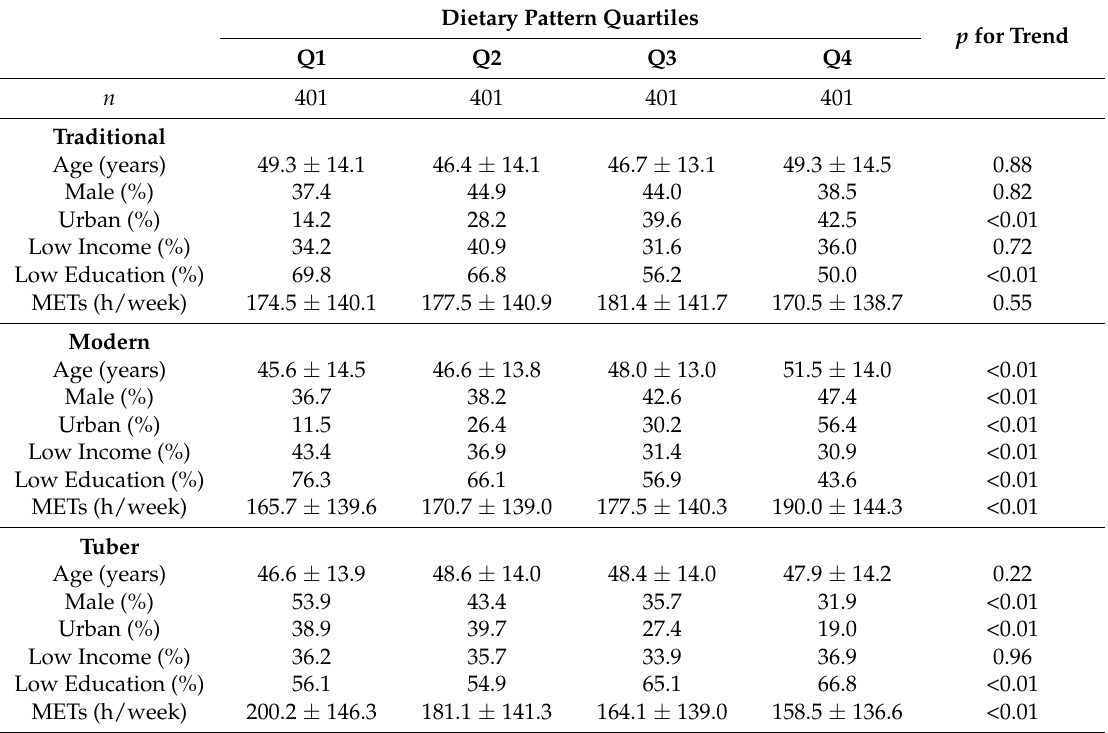
Table 3. Socio-demographic characteristics across quartiles of dietary patterns among adults in Southwest China.